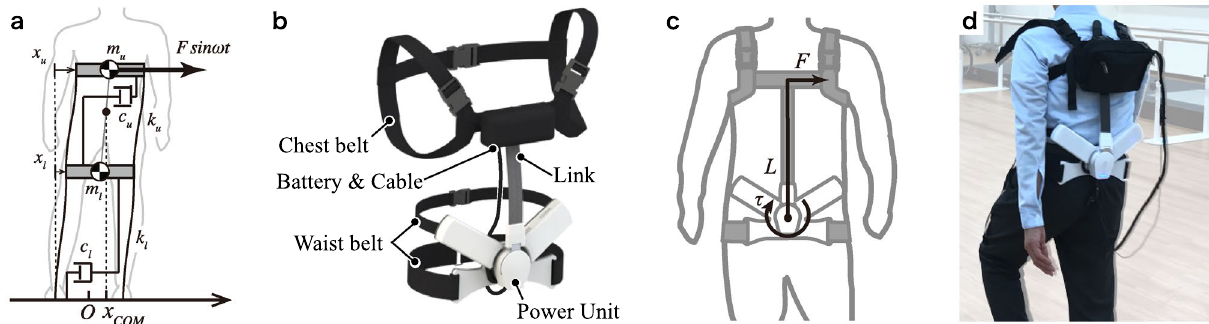
Figure 1. A wearable cyborg Hybrid Assistive Limb (HAL) trunk unit can provide lateral cyclic force to the chest. ( a ) Simplified model of the frontal plane. ( b ) Outside of the HAL unit. ( c ) Force transmission by HAL. ( d ) Walking with the HAL unit. The rendering function of SOLIDWORKS 2018 was used to create part of the image. We previously developed a system and evaluated the basic function of parkinsonian patients as a case study 30,31 .